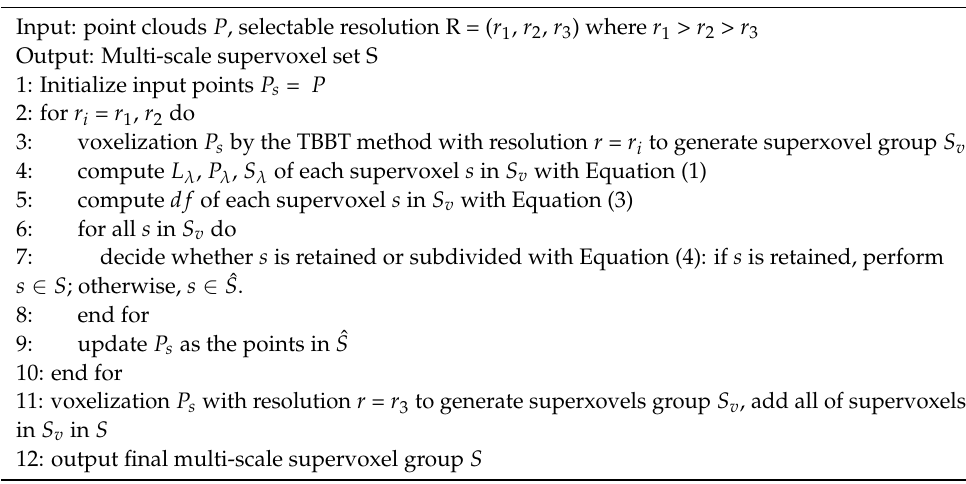
Algorithm 1. Multi-scale supervoxel